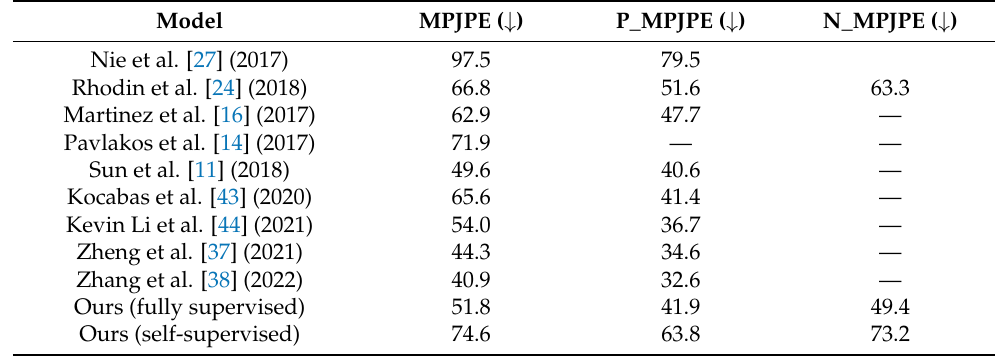
Table 1. Comparison of results between the proposed method and other fully supervised methods.